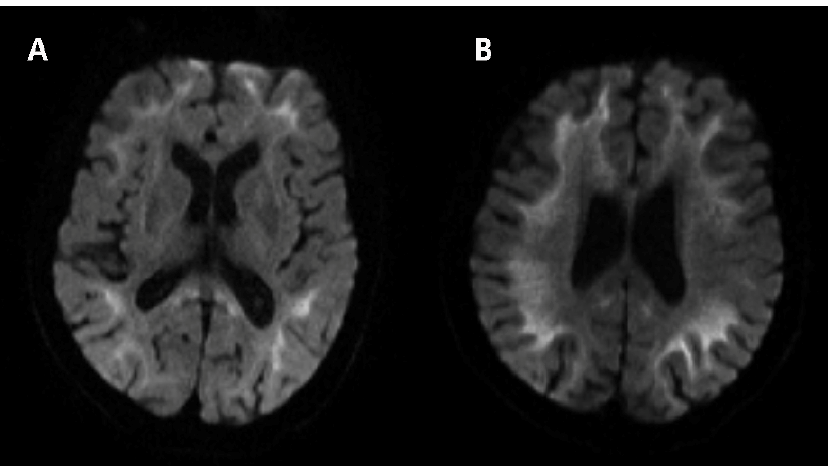
Figure 2. Brain diffusion-weighted imaging (DWI) sequence of magnetic resonance imaging (MRI) in the axial view showed high-signal-intensity zigzag edging sign in the corticomedullary junction which were exampled by the sections of basal ganglia ( A ) and centrum semiovale ( B ). The typical “cortical line sign” in DWI of the brain combined with eosinophilic hyaline intranuclear inclusions in the skin biopsy supported the diagnosis of NIID. No family member had similar symptoms or the FMR1 gene premutation. The patient was finally diagnosed with sporadic NIID. With regard to the corneal impairment, we reviewed the pathogenic factors of the secondary neurotrophic keratitis along the pathways of the corneal sensory nerve, including the following causes: (1) injuries of corneal sensory nerves induced by viral infection, refractive surgery, chemical or thermal burns, ocular medication and wearing contact lenses; (2) damage of the ophthalmic branch of the trigeminal nerve, as well as ciliary nerves, due to tumor formation and surgeries (such as cataract and retinal surgeries or ophthalmic laser procedures); (3) trigeminal ganglion lesions due to herpetic viral infections, surgery for trigeminal neuralgia, preganglionic trigeminal nerve root injury (including acoustic neurinoma, schwannoma and aneurysms) and some systemic diseases (such as diabetes and leprosy) that can decrease sensory nerve function or damage sensory fibers; and (4) damage to the lowest part of the spinal trigeminal nuclei due to dorsolateral medullary infarction and tumor formation [9,10]. However, our patient developed keratopathy without any of the abovementioned histories, and neurotrophic keratitis due to the autonomic nervous dysfunction of NIID was established. The patient had a regular follow-up visit, but she was distressed because the neurological symptoms progressed, and the decreased vision affected every aspect of her